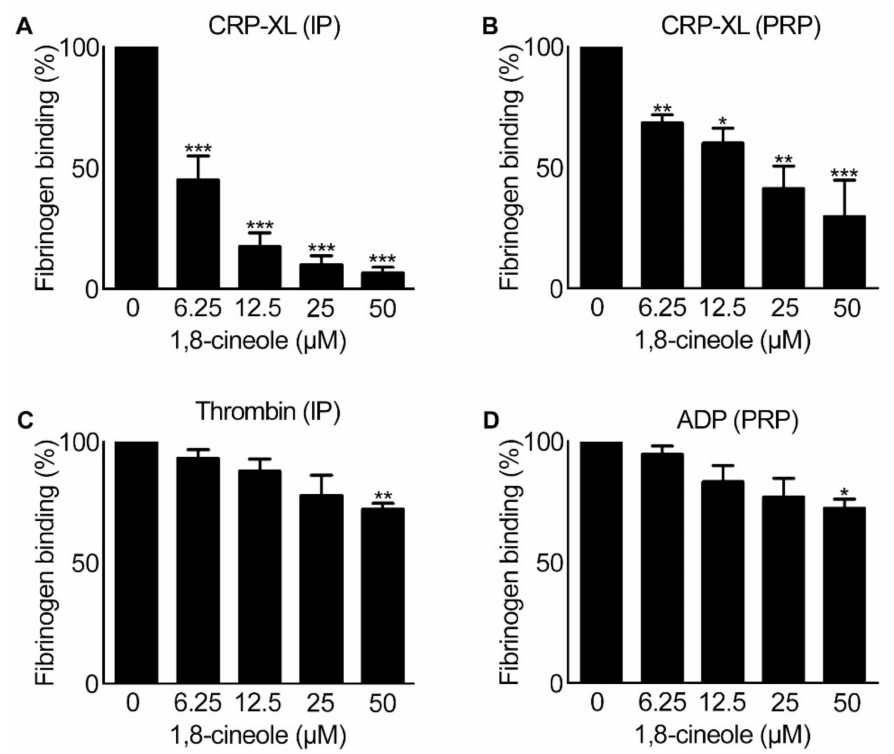
Figure 4. Effect of 1,8-cineole on inside-out signalling to integrin α IIb β 3 in human platelets. Human isolated platelets (IP) or PRP were incubated with a vehicle control [0.01% ( v/v )